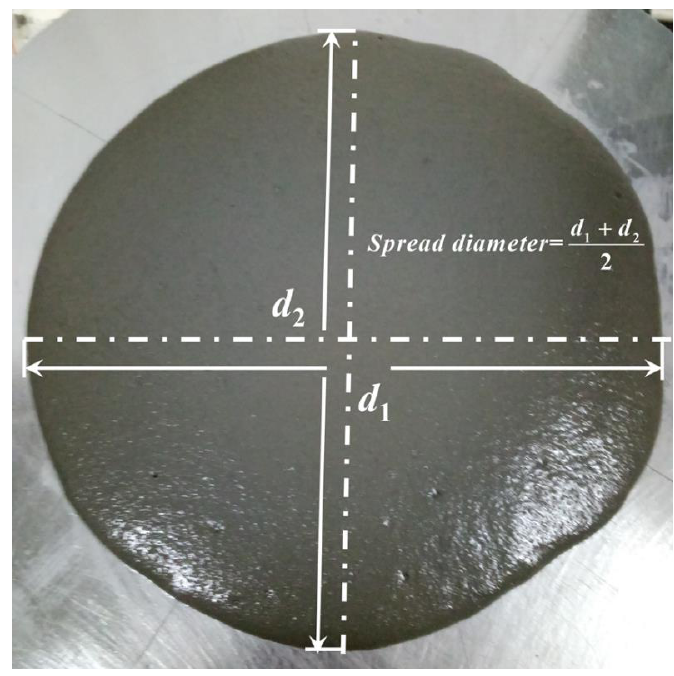
Figure 6. Schematic diagram of workability test.